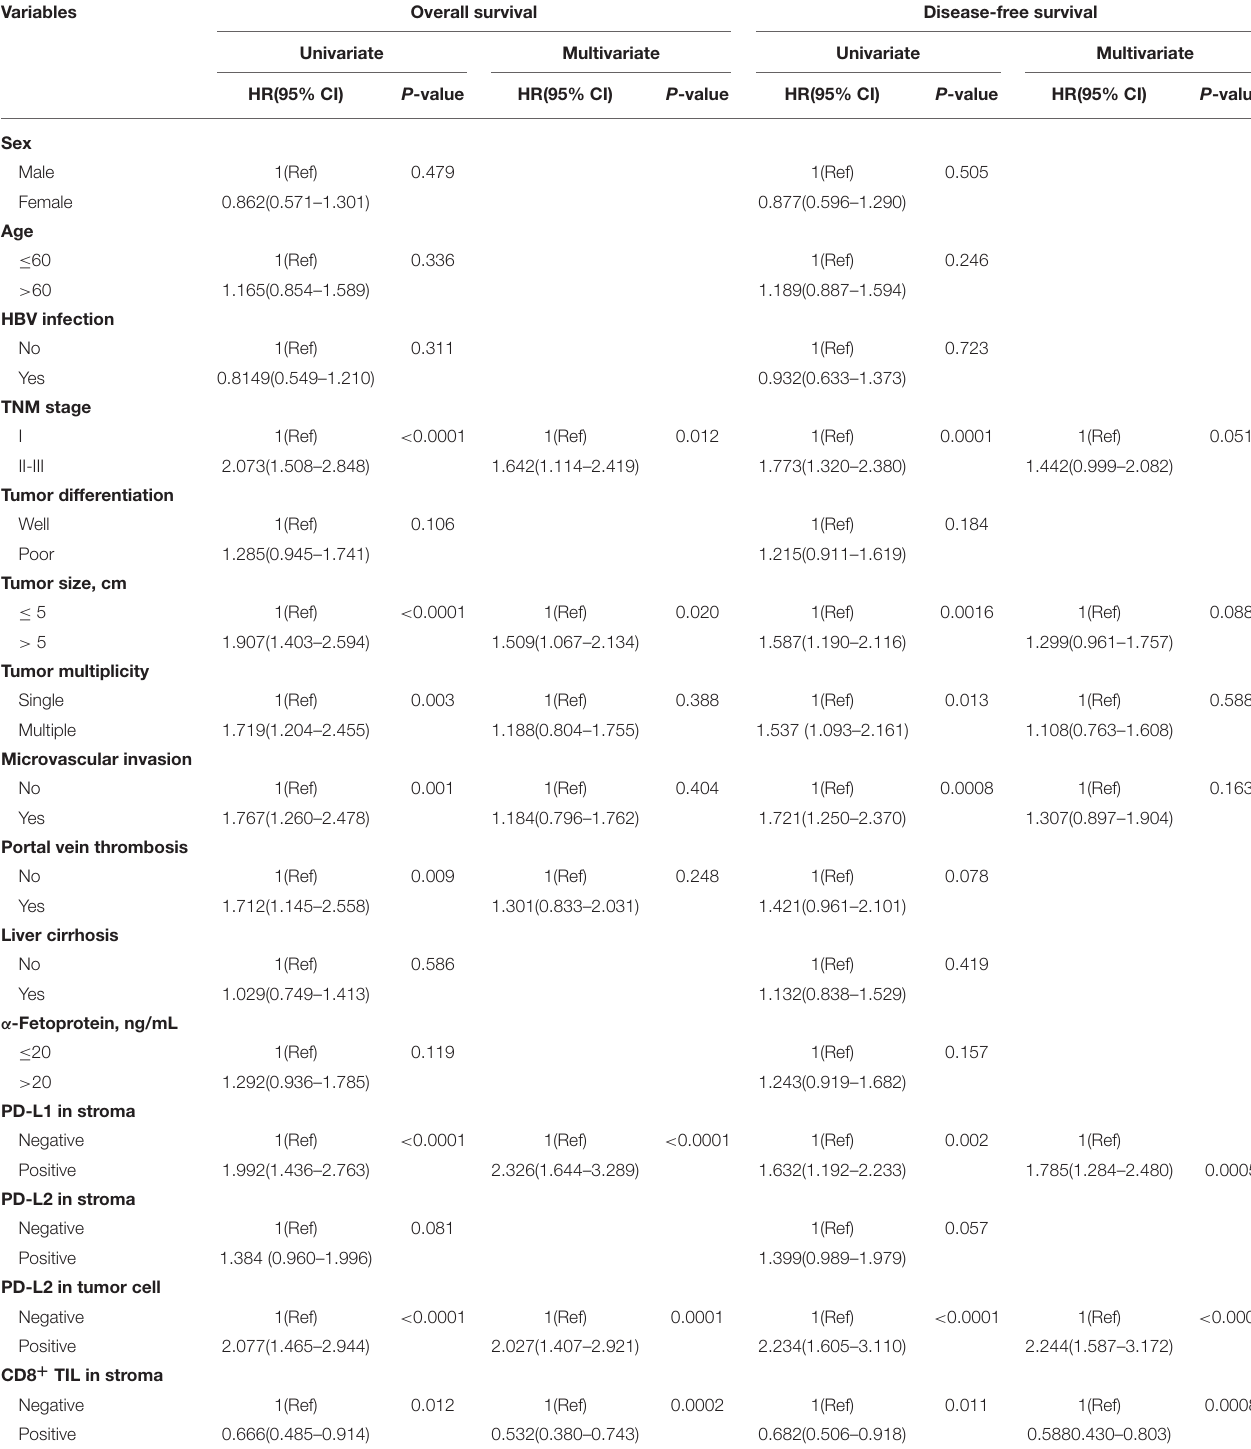
TABLE 2 | Cox proportional hazard model showing hazard ratios for survival outcomes conferred by